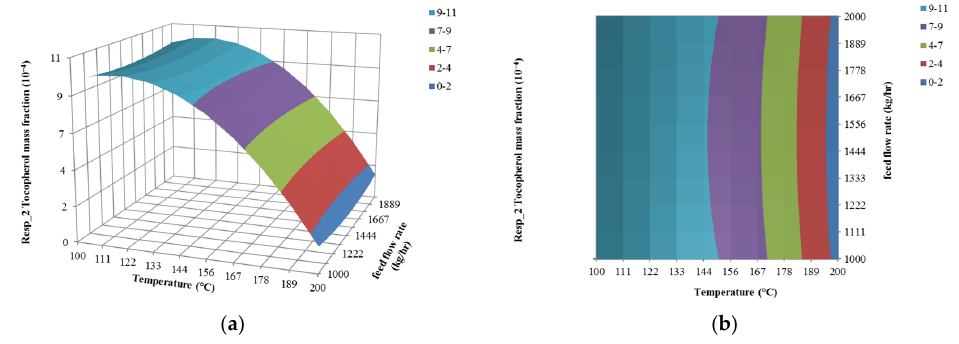
Figure 6. Response surface curve ( a ) and contour plot ( b ) of tocopherol concentration as a function of temperature and feed flow.